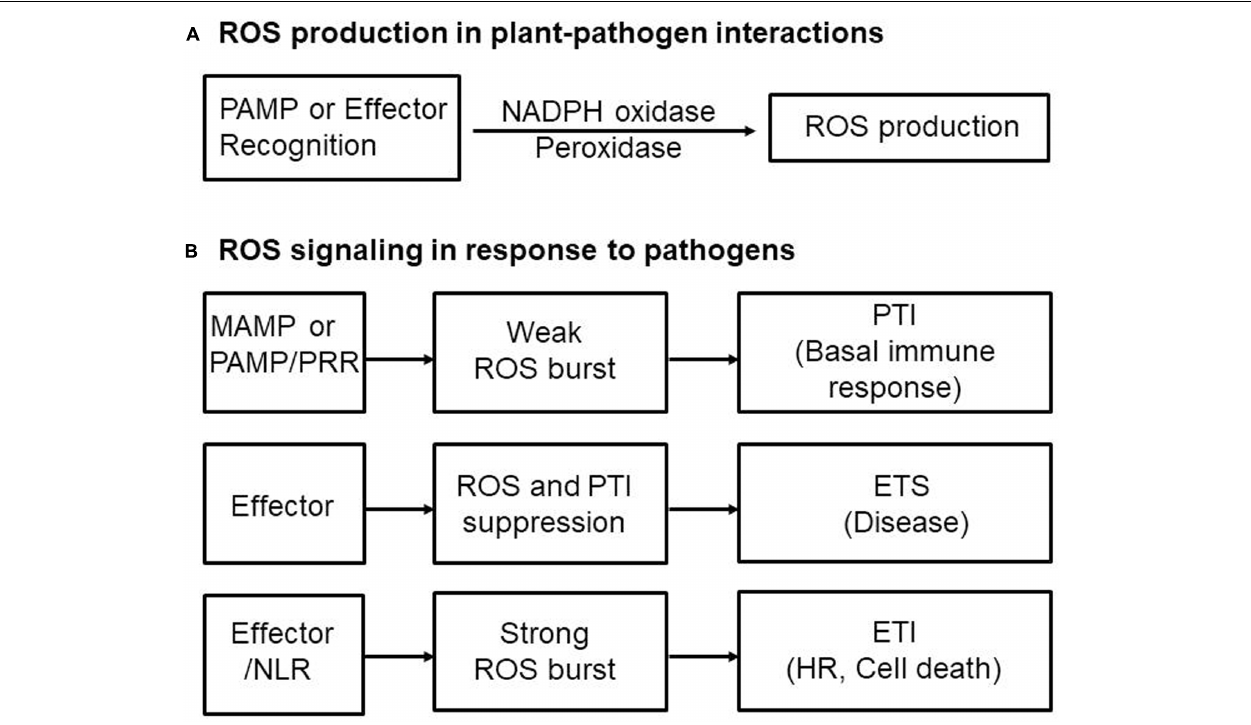
FIGURE 2 | Reactive oxygen species (ROS) production and signaling in plant-pathogen interactions. (A) Perception of microbe- or pathogen-associated molecular patterns (MAMPs or PAMPs) or effectors by plants via membrane-bound pattern recognition receptors (PRRs) or intracellular nucleotide-binding leucine-rich repeat (NLR) receptors, respectively, activates NADPH oxidases as well as peroxidases, triggering ROS production and the ROS burst. (B) Perception of MAMPs or PAMPs by PRRs induces weak ROS bursts, leading to PAMP-triggered immunity (PTI)-dependent basal defense responses. Adapted pathogens secrete virulent effector proteins into plant cells to suppress the ROS burst and PTI, resulting in effector-triggered susceptibility (ETS) to cause disease in their respective host plants. Pathogen avirulence (Avr) effectors interact directly or indirectly with intracellular NLR proteins, leading to a strong ROS burst and HR cell death response, key components of effector-triggered immunity (ETI). ETI is an accelerated and amplified PTI response, resulting in disease resistance and, usually, a resistance ( R ) gene-mediated HR cell death response at the infection site in